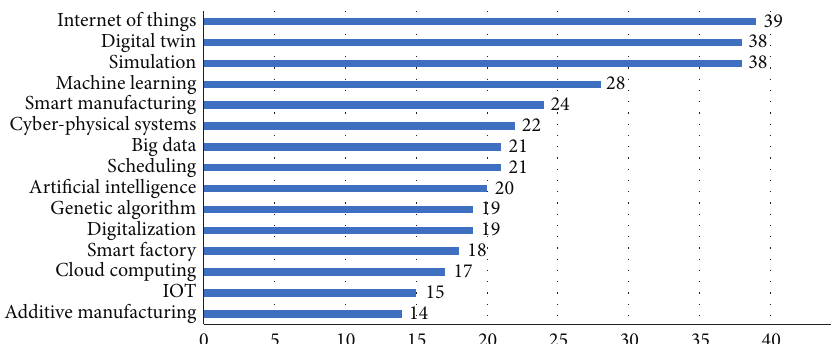
Figure 6: Frequency of the most commonly occurring keywords.